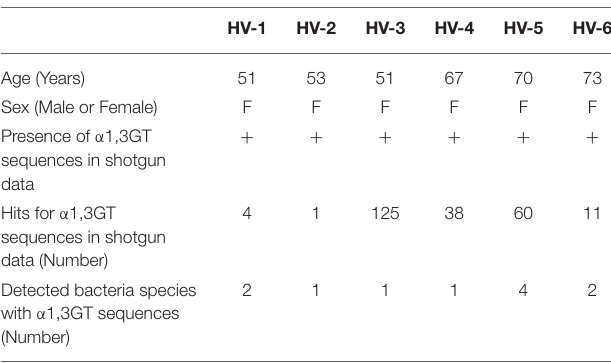
TABLE 2 | Characteristics of healthy